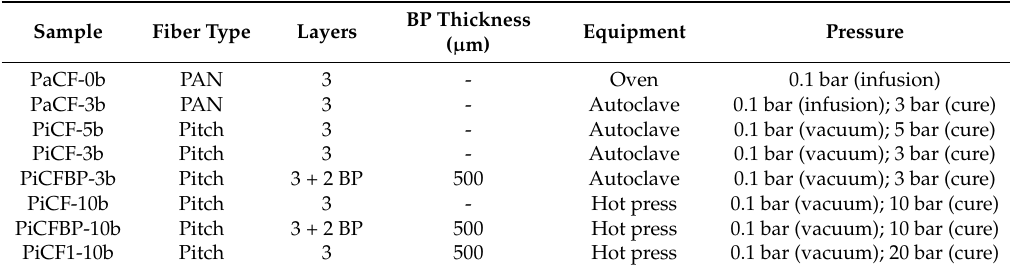
Table 14. Manufacturing conditions and observations of CFRP sample